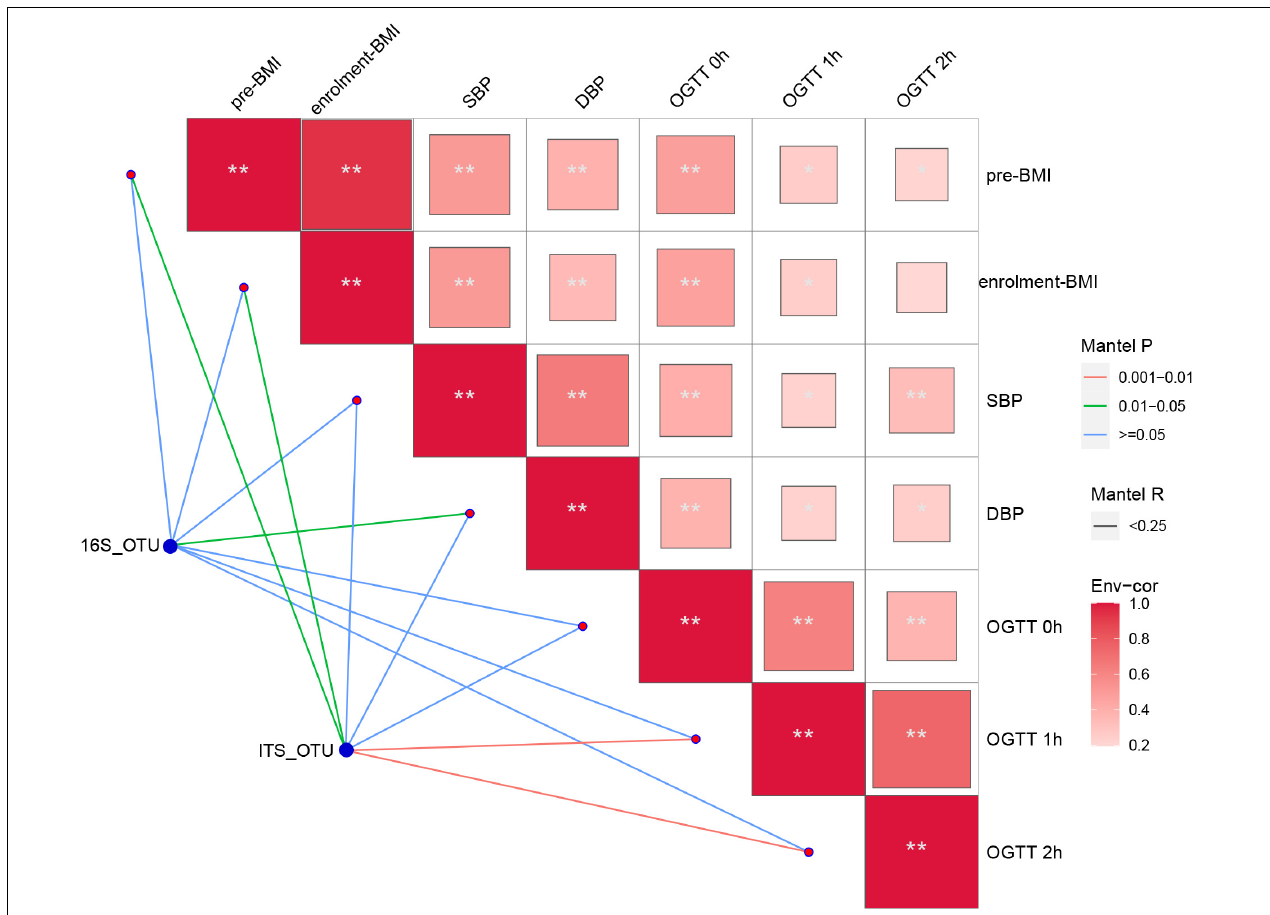
FIGURE 5 | Fungal OTUs and the 16S OTUs associated with clinical metabolic parameters was determined by Mantel analysis. The co-occurrence network shows the correlations of the fungal and bacterial microbiota with the clinical metabolic parameters. The color of lines between nodes indicate significant (red line: positive correlations with P < 0.01 and green line: positive correlations with P < 0.05) or non-significant (blue line) correlations. Blue nodes: bacterial and fungal microbiota involved in GDM group; red nodes: the clinical metabolic parameters. Asterisk in square indicating relationship between the clinical metabolic parameters, ** P < 0.01, * P <